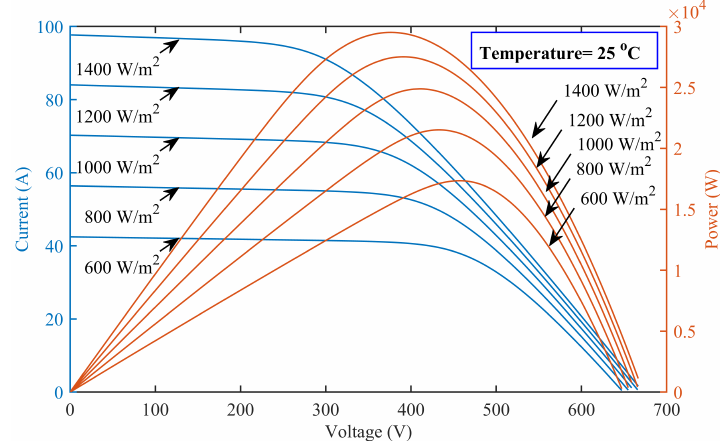
Figure 4. Characteristic curves of P-V and I-V under varying irradiance.